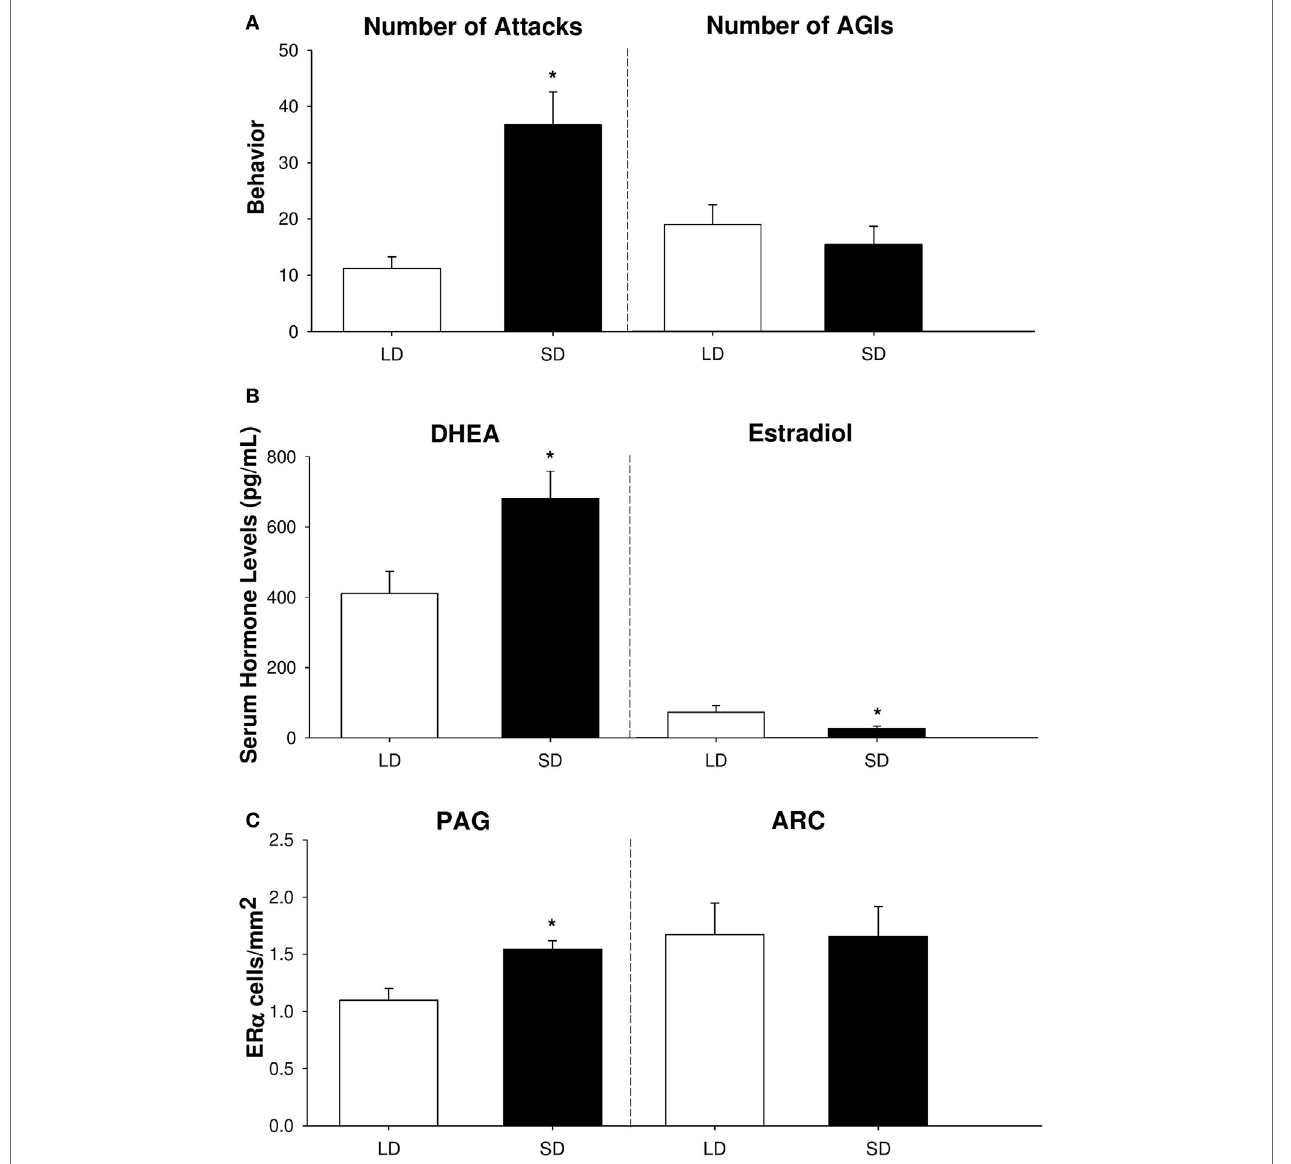
FiGURe 2 | Aggressive behavior, serum hormone profiles, and neural estrogen receptor- α (ER α ) abundance differ across reproductive phenotypes of female Siberian hamsters. (A) Number of attacks and anogenital investigations (AGIs), (B) serum dehydroepiandrosterone (DHEA) and estradiol levels (in pg/mL), and (C) ER α cell density (in cells/mm 2 ) in the periaqueductal gray (PAG) and arcuate nucleus of the hypothalamus (ARC) in short-day and long-day female hamsters following 10 weeks of photoperiodic treatment. Bar heights represent mean ± SEM. “*” indicates a significant difference between groups ( P < 0.05). Data are modified and reprinted with permission from the authors (25,